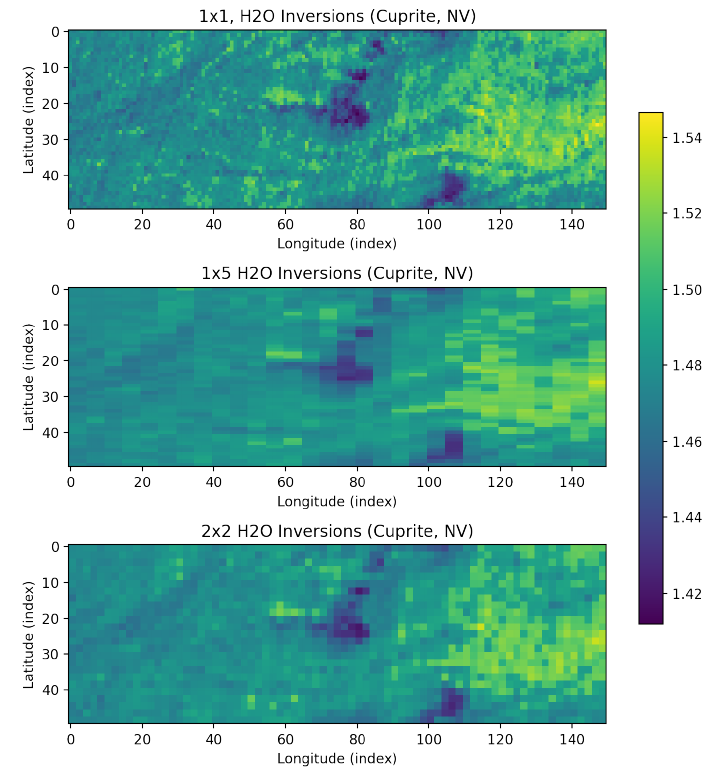
Figure 9. The water vapor (units of g/cm 2 ) estimates are noticeably smoother under the spatial models. The predicted fields are qualitatively more realistic and are a principled alternative to post-hoc